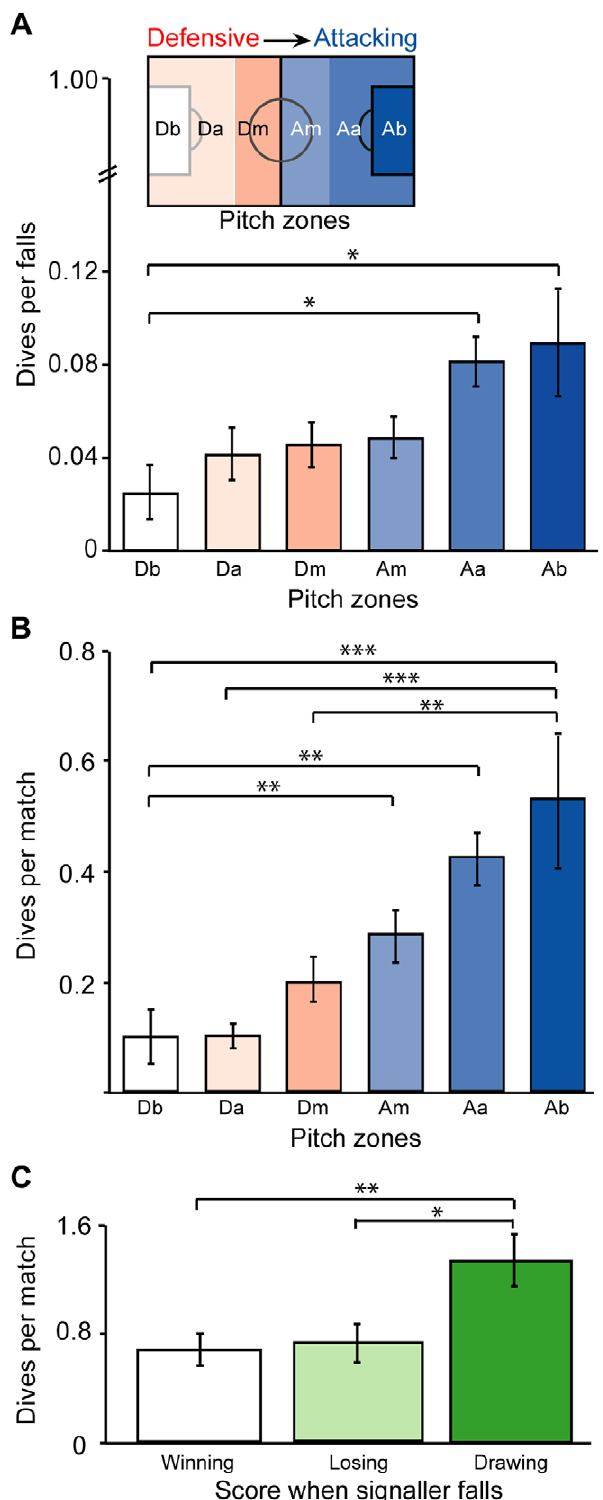
Figure 1. Deception across pitch zones and team scores. Dive use by soccer players is expressed as (A) the mean proportion of total falls per match that were dives; (B) the mean frequency of dives per match across pitch zones (corrected for spatial area) ordered by increasing distance from the defensive goal (see insert); and, (C) the mean frequency of dives per match that were signalled when the player was winning, losing or drawing. Standard error bars are presented